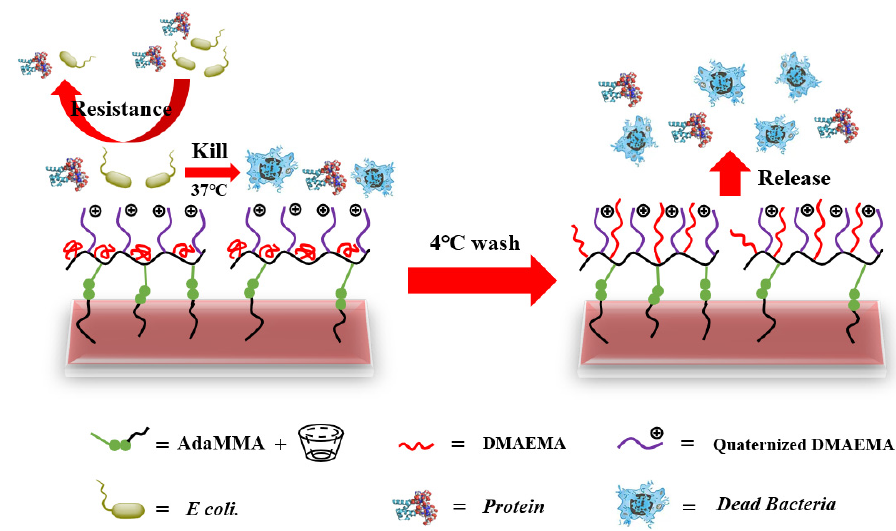
Figure 12. The mechanism of “resistance–kill–release” of PAdaM3QA coating.